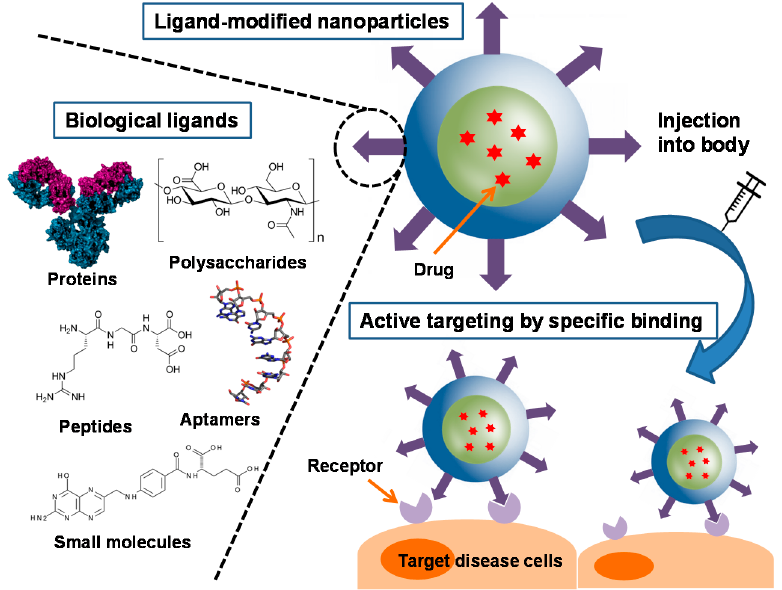
Scheme 1. Illustration of biological ligands for active targeting of nanoparticle drug Table 1. Ligands for active targeting of nanoparticle drug delivery systems.